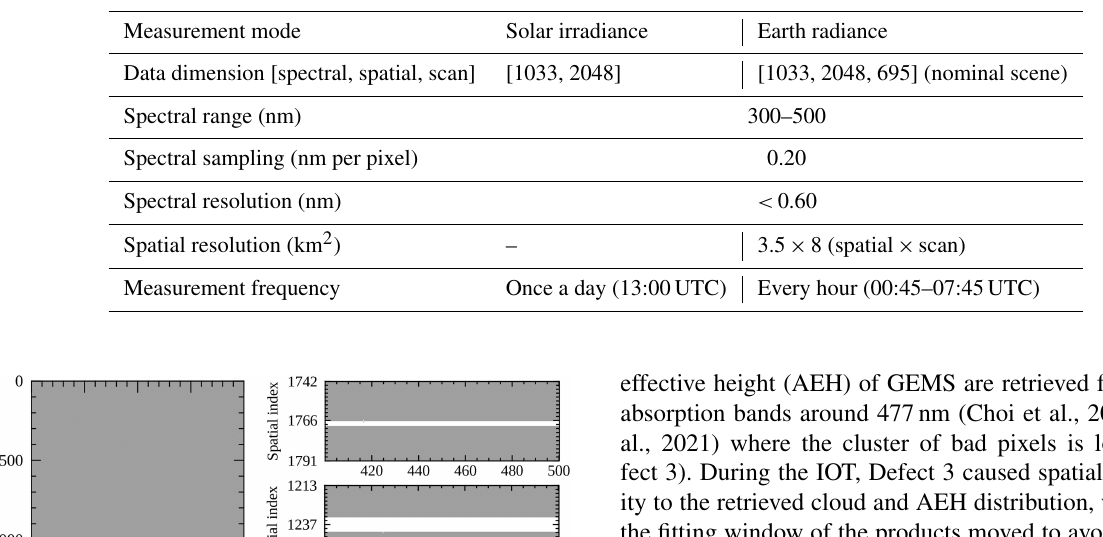
Table 1. Top level measurement specifications of GEMS.